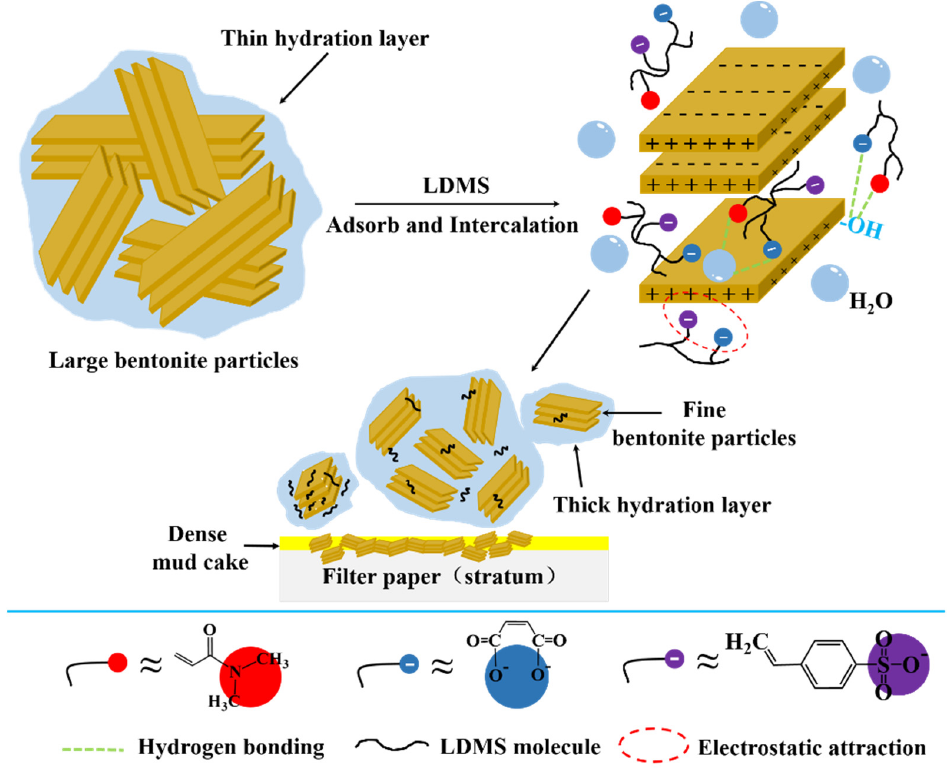
Figure 13. Mechanism of the low-molecular-weight filtrate reducer (LDMS).